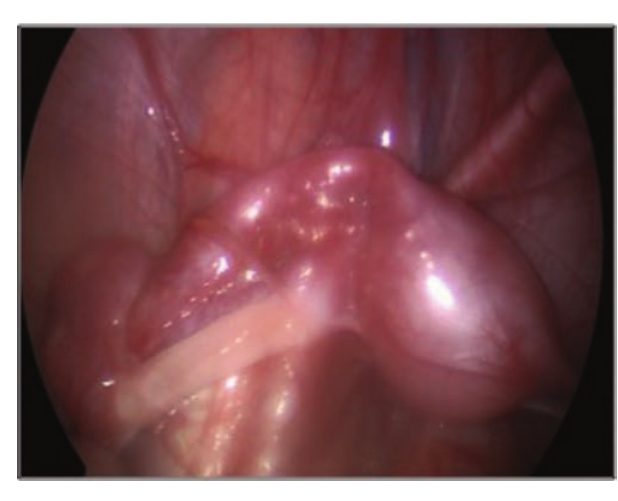
Figure 2. Laparoscopic image of streak